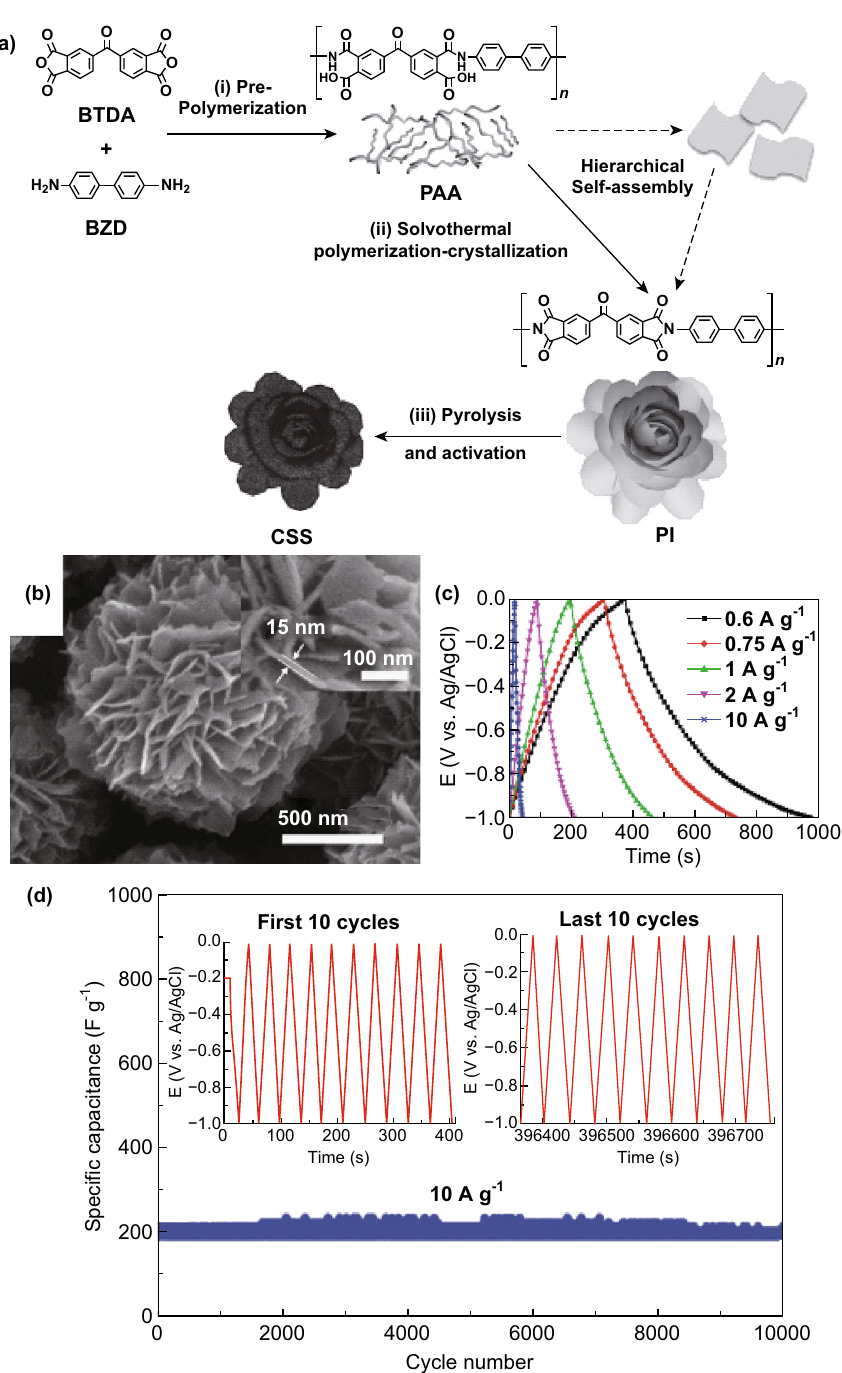
Fig. 2 3D architectures based on 2D carbon nanoflake ensembles for supercapacitors. a Overall fabrication of 3D carbon superstructures. b SEM images of carbon materials with various hierarchical structures, derived from polyimide. c Galvanostatic charge/discharge curves at various current densities and d cycling performance at a current density of 10 A g - 1 , indicating excellent cycling stability of N-doped porous carbons. Reproduced with permission [56]. Copyright (cid:2) 2016, John Wiley & Sons,